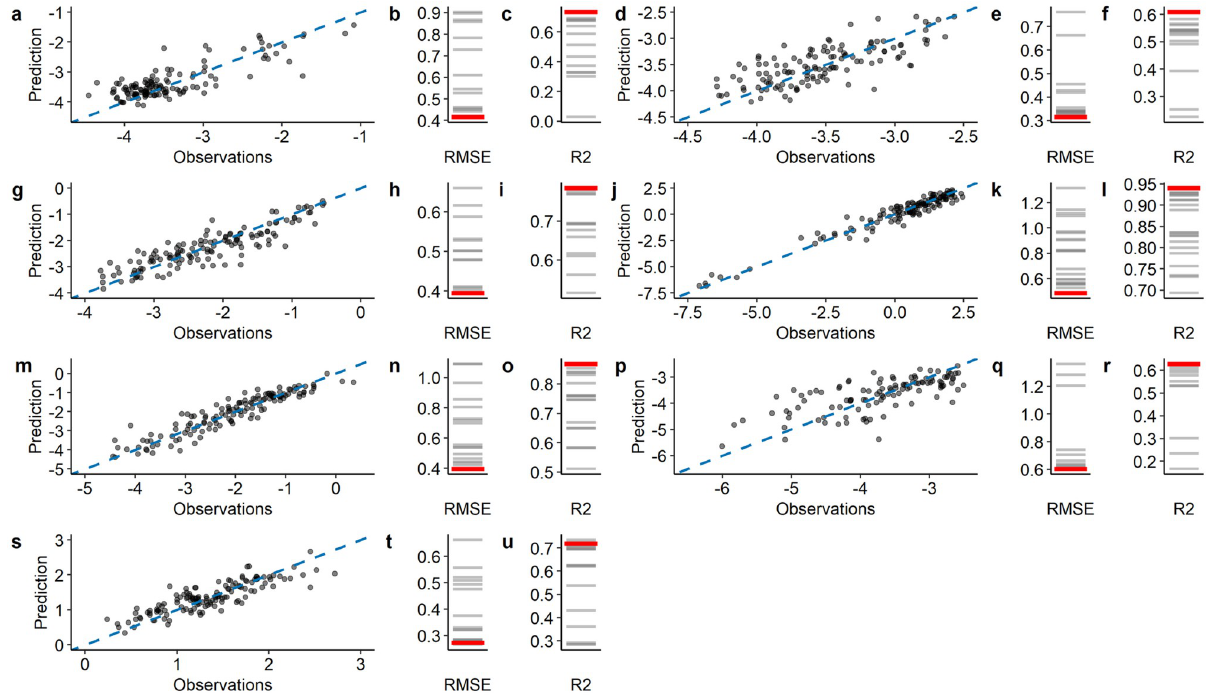
Fig 3. Performance of the super learners for the seven target variables: (a-c) Managers and professionals, (d-f) Technicians and associate professionals, (g-i) Clerks and service workers, (j-l) Agricultural workers, (m-o) Craft workers and operators, (p-r) Elementary occupations and (s-u) Labor force participation rate. The large panels compare the district-level observations with the super learner predictions for the hold-out dataset (n = 136). The dashed blue line represents the 1:1 line. Small panels show the RMSE and the R 2 for the super learners (red lines) and member models (gray lines) for the hold-out dataset. Predictions and observations are logit transformed